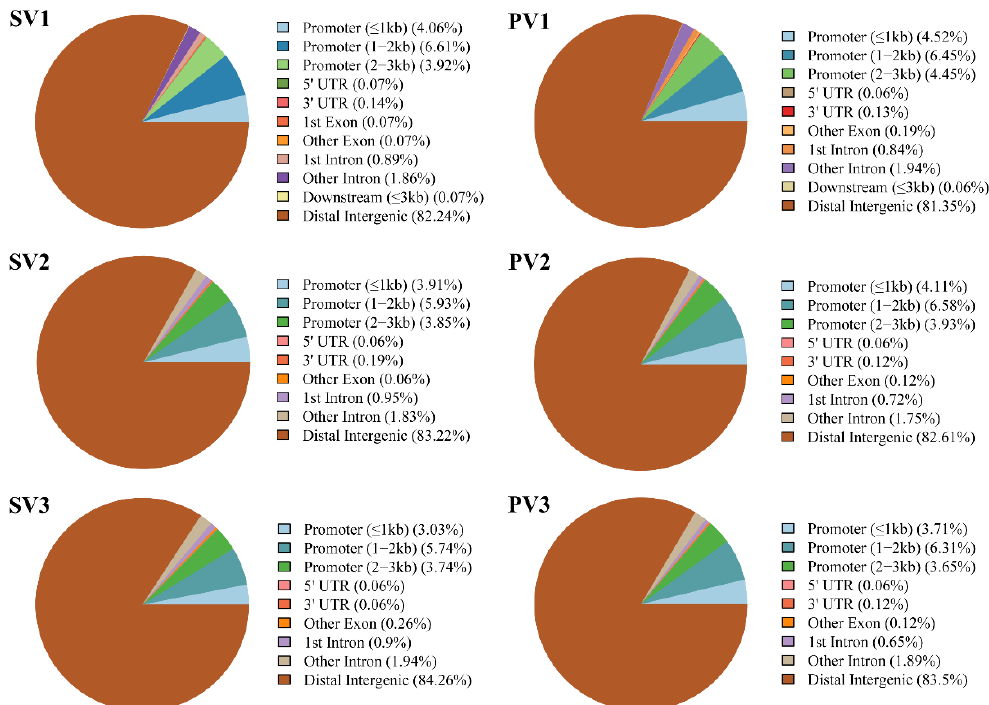
Figure 5. The percentages of hypermethylation CG island (CGI) regions distributed in different gene regions of pecan genome. SV1, SV2, SV3: grafts with strong growth vigor; PV1, PV2, PV3: grafts with poor growth vigor. UTR: untranslated region.